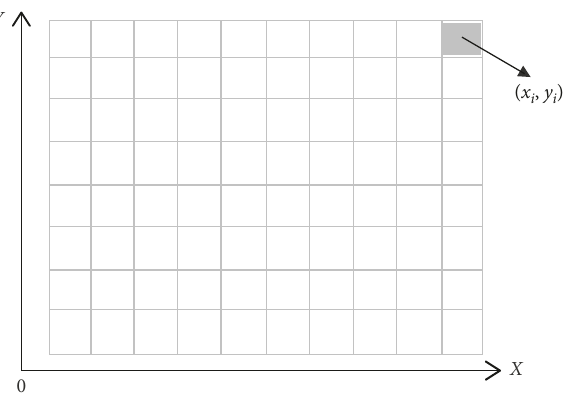
Figure 16: Indoor plane: establishing Cartesian